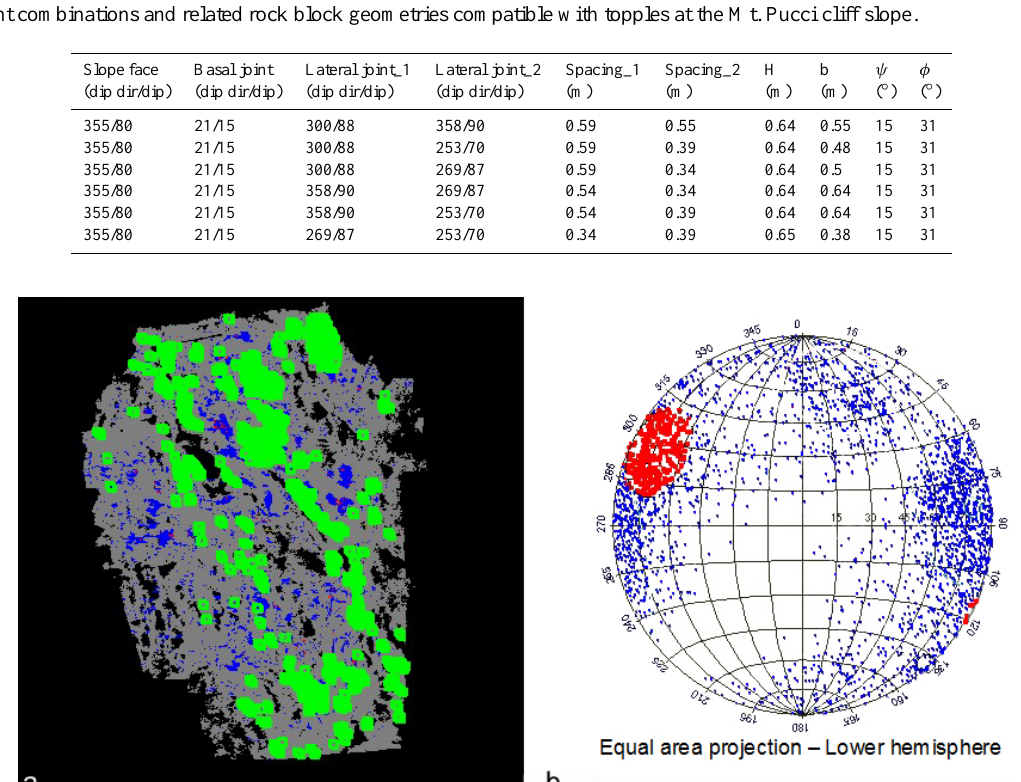
Fig. 6. Sketch showing the results of the automatic detection of the main joint sets from a laser scanner-georeferenced points cloud; (a) points cloud of a portion of the cliff (grey color) with the automatic identification of planes (blue color) and selection of some planes of the same joint set (green dots); (b) stereo plot showing the poles of the planes automatically detected (blue dots) on the points cloud and poles selected in the side image (red